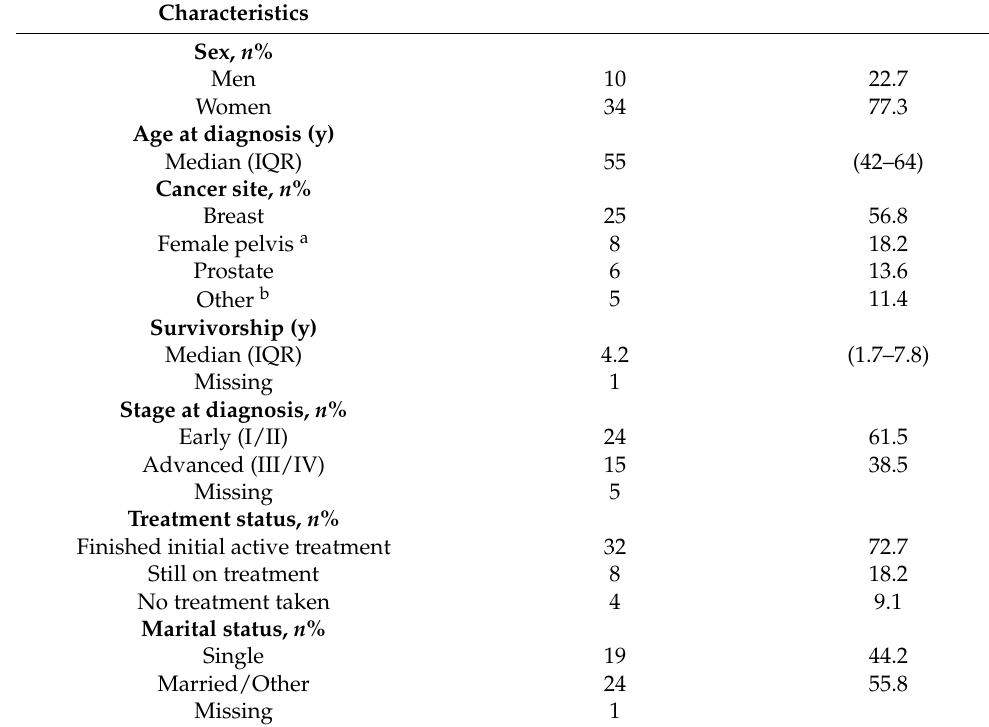
Table 1. Sociodemographic characteristics of the 44 cancer survivors included in the current study who had responses for at least one of the three